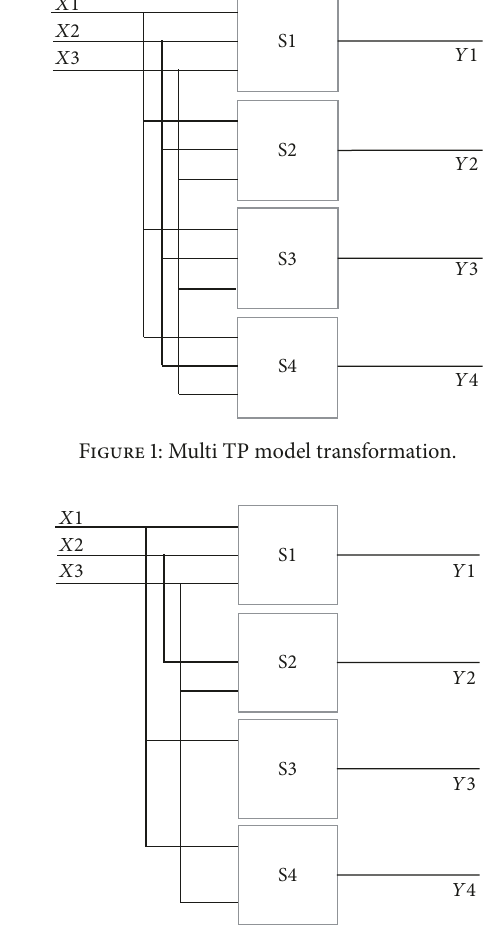
Figure 2: Proposed extension of the TP model